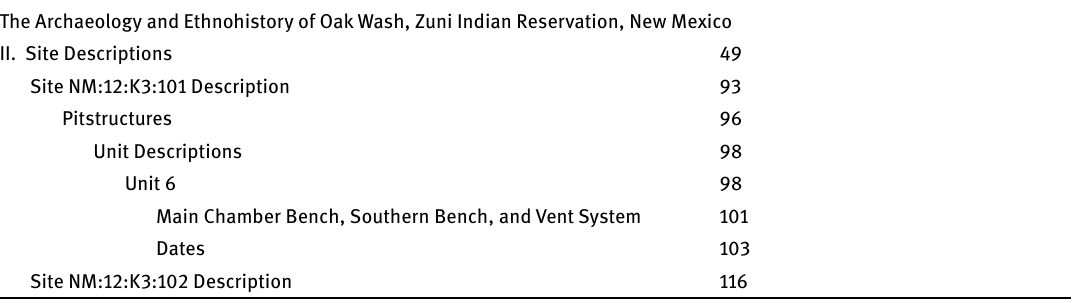
Figure 2: Hierarchy of section headings in the report [12] contextualizing Figure